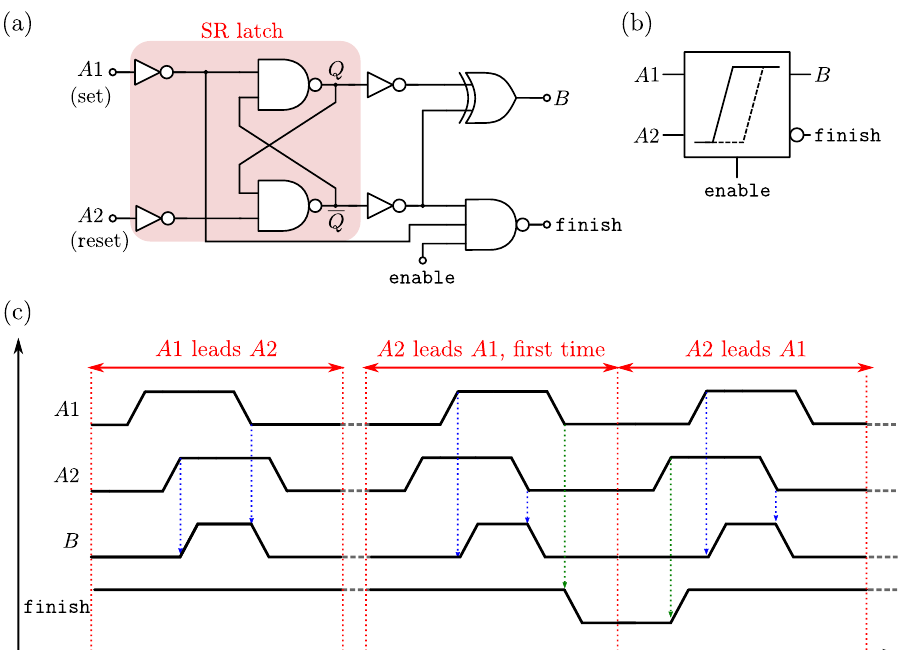
Figure 4. Time-delay comparator: ( a ) schematic diagram, ( b ) symbol view and ( c ) chronogram when operated inside the synchronized delay chains